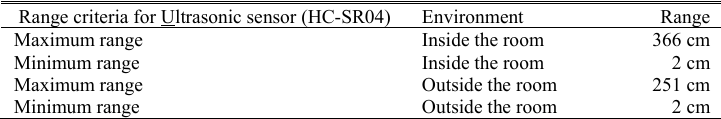
TABLE 2 R ANGE D ETECTION OF P ROPOSED R ADAR S YSTEM AT D IFFERENT E